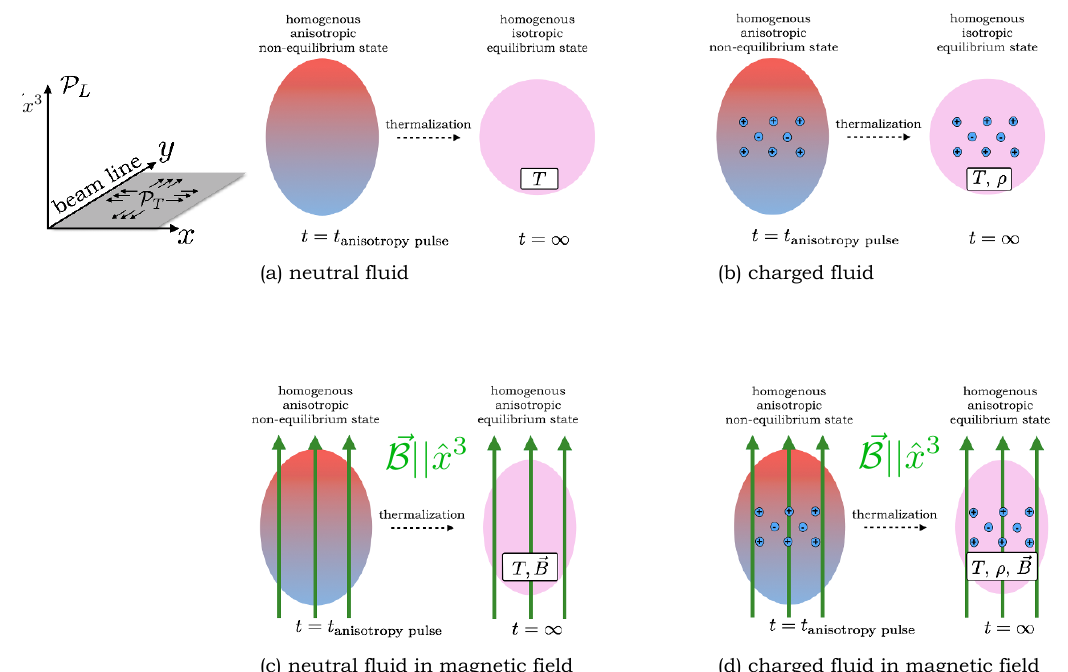
Figure 1 . Schematic sketch of the four types of thermalization processes considered in this work. In each of the sub(cid:12)gures (a){(d), a homogeneous anisotropic non-equilibrium state evolves into a homogeneous equilibrium state characterized by temperature T , charge density (cid:26) , and magnetic (cid:12)eld ~B . The beam line can be chosen along the y -direction. We distinguish two sources of anisotropy, namely the initial anisotropy of the (cid:13)uid and the anisotropy due to the presence of the magnetic (cid:12)eld ~ B . Both of these anisotropies distinguish the x 3 -direction (longitudinal) from the x - and y -directions (transverse). Accordingly, a pressure anisotropy (cid:1) P = P T (cid:0) P L is given by the di(cid:11)erence between longitudinal pressure P L (along the x 3 -direction) and transverse pressure P T (in the x; y